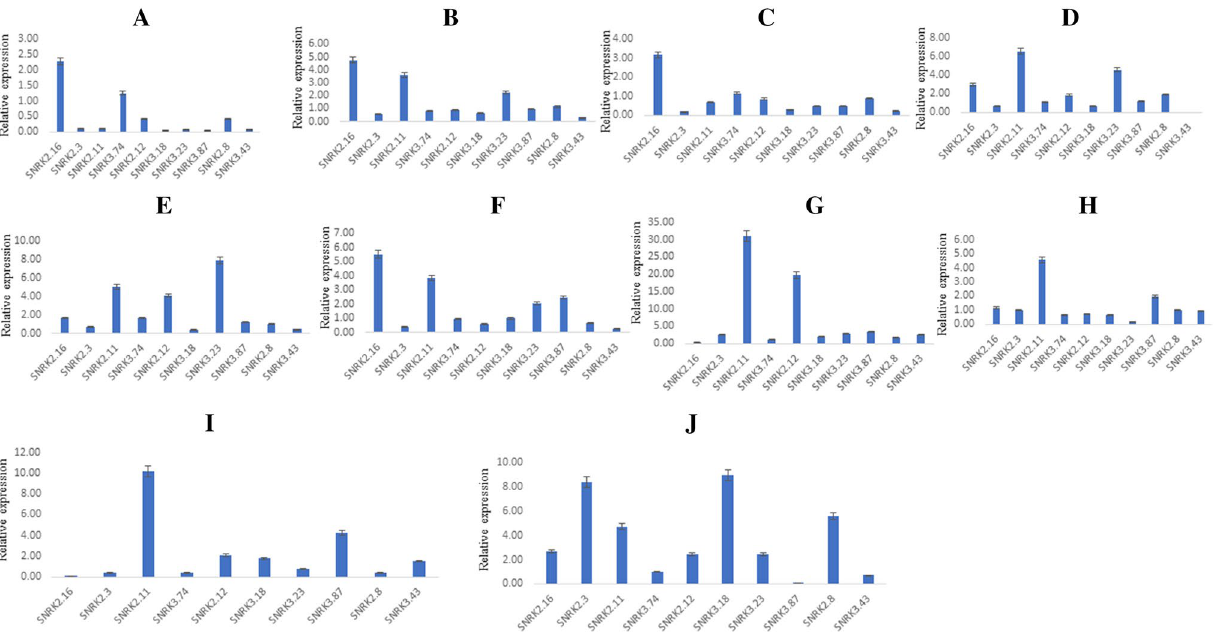
Figure 8. qRT-PCR based differential expression analysis of 10 TaSnRK genes under abiotic stress. Heat stress treatment at 37 °C ( A ) HS240, & ( B ) RAJ3765; Heat stress treatment at 42 °C ( C ) HS240, & ( D ) RAJ3765; Salt stress treatment at 150 mM NaCl ( E ) Kharchia65, ( F ) HD2687 at 12 h and ( G ) Kharchia 65, ( H ) HD 2687 for 24 h; drought stress at 25% (v/v) PEG treatment ( I ) C306 and ( J ) Wl711 for 24 h. The error bars indicate the standard deviation.